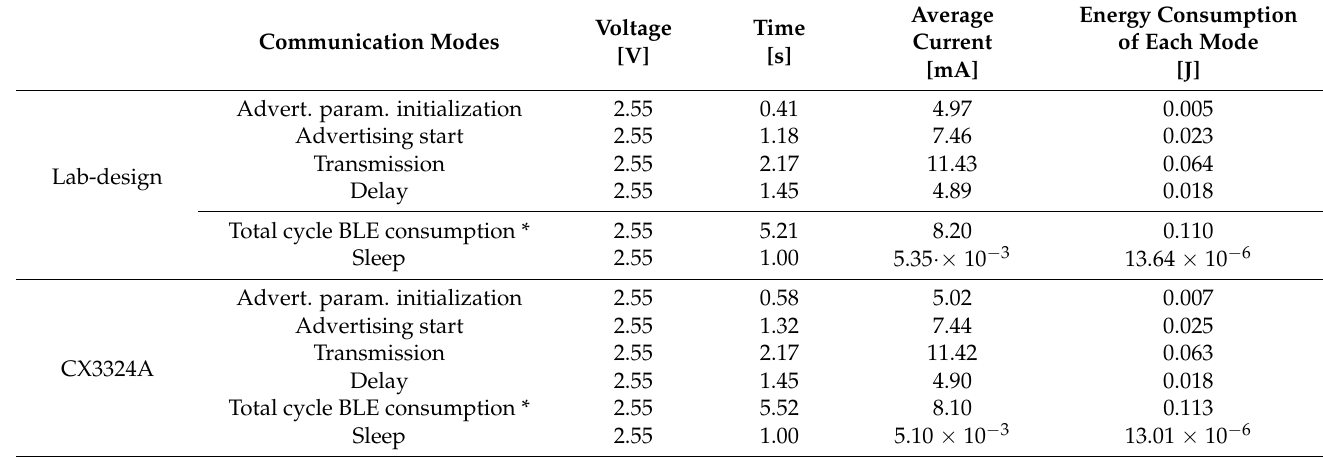
Table 4. Energy consumption of the IoT device in one BLE communication cycle.